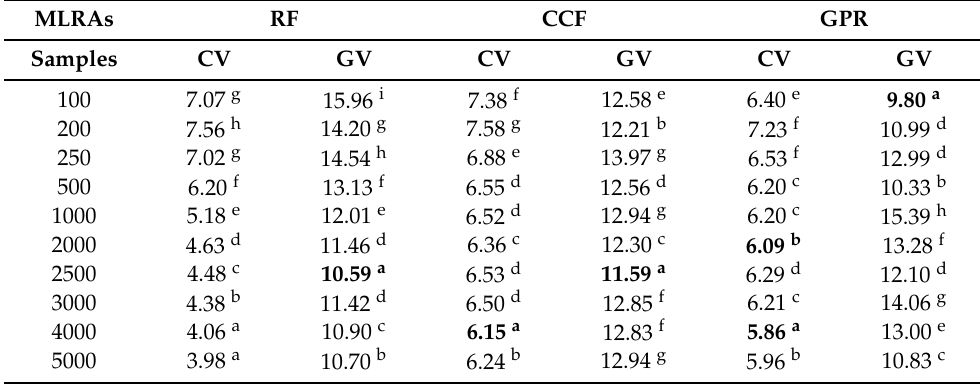
Figure A2. Scatterplots of LAI ( A ), fCover ( B ), and CCC ( C ) obtained from LUTstd using all data (156 samples); and the trend lines for linear fitting (black) and 1:1 line (dashed red). Table A2. Average NRMSE % of 10 replicates based on cross-validation and ground validation under different sample sizes and machine learning methods for LAI